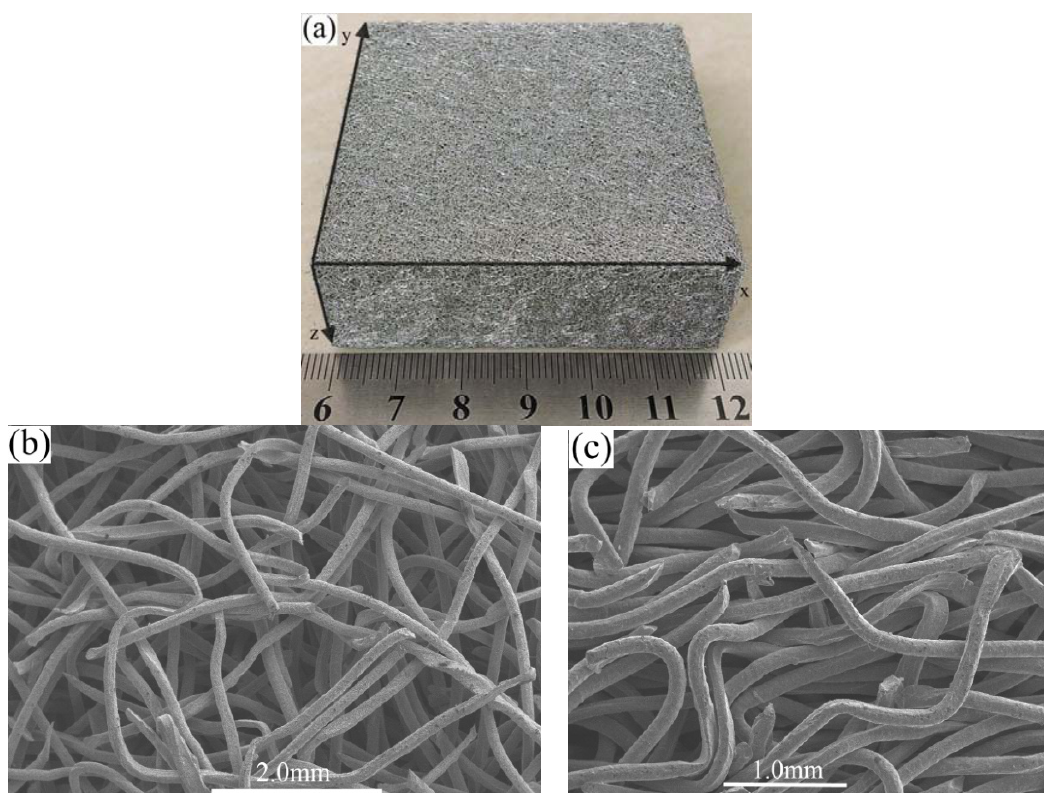
Figure 2. Images of the stainless steel PTSWMs: ( a ) macroscopic appearance and SEM images with 69.5% porosity; ( b ) in-plane ( x-y plane) direction; ( c ) through-thickness direction ( x-z plane).